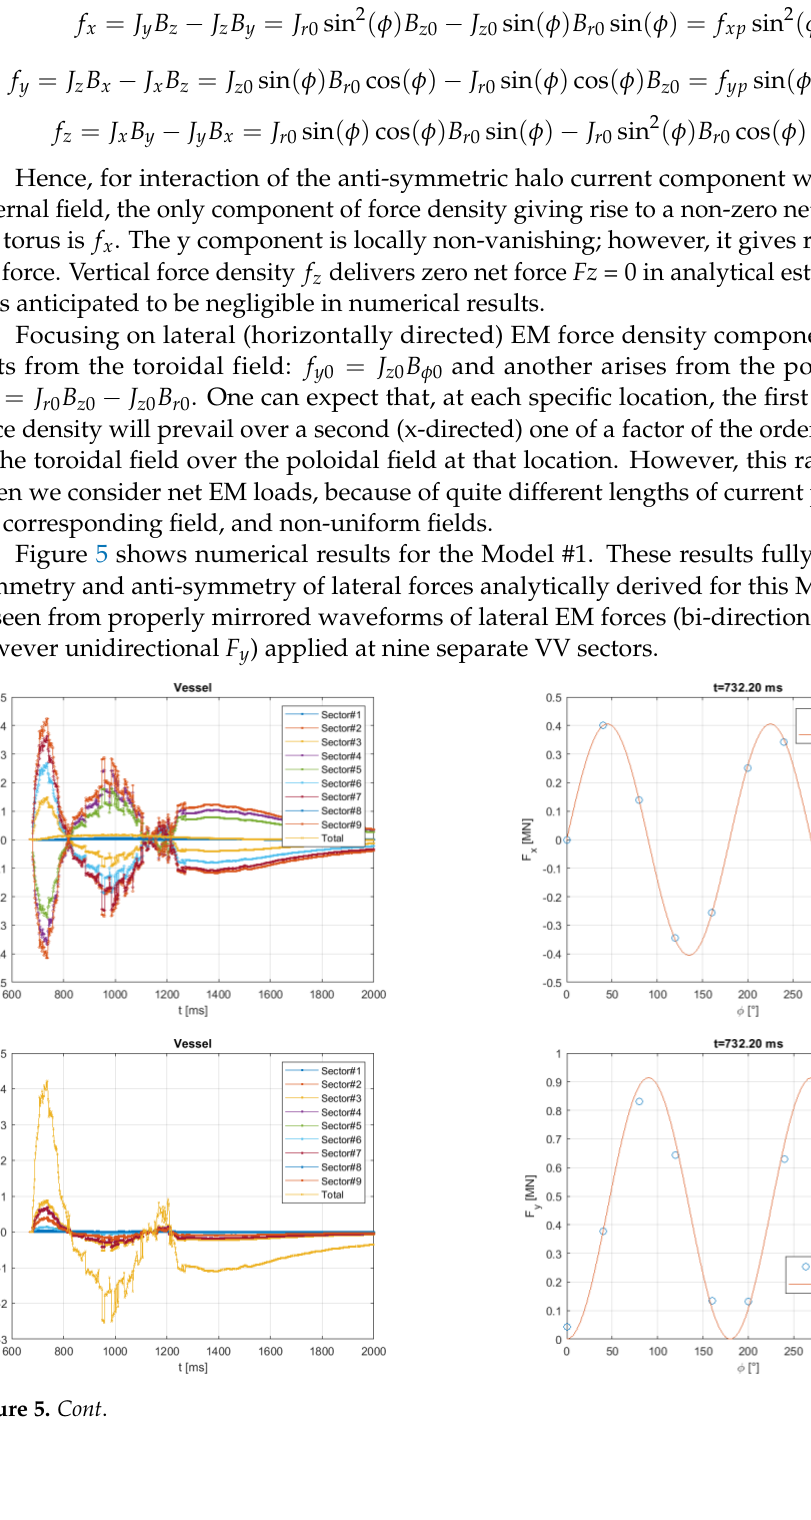
Figure 5. Force Cartesian components created in 9 sectors of the vessel itself due to interaction of the anti-symmetric halo current component in VV with external toroidal magnetic fields, for the Model #1. 6. Model #2 of Bridges for the Perfectly Anti-Symmetric Halo Current Component The main advantage of the first model presented in previous section is that it simu- lates gradual slipping of the halo current “injection belts” down along the first wall, ex- actly in the same way as already done in VDE post-processing, e.g., in [6]. However, as a main disadvantage, it does not reproduce details of magnetic fields caused by asymmetric distortion of helical current in the plasma Halo layer; thus, it does not reflect the interac- tion of helically distorted magnetic fields with all currents, neither does it reflect helical eddy currents in VV with internals, and, accordingly, misses some components of asym- metric loads applied at VV and the Magnets. This section describes a new model of helical bridges for the perfectly anti-symmetric halo current component proposed by this article. It is marked as Model #2 and illustrated by Figures 6 and 7, with results presented in Figures 8 and 9. It uses the same mesh of VV with internals as shown in Figure 3, but differs from the model#1 by helical (not poloidal) bridges closing the anti-symmetric halo currents around plasma. Figure 6 shows only these helical bridges, but not the rest of the FE model already presented in Figure 3. Right now, Model #2 assumes fixed location of the halo current injection belts. We can say that, in comparison with Model #1, Model #2 has both main features in- verted. It represents, as far as possible, the helical pattern of anti-symmetric halo currents in a course of AVDE; however, it still waits for upgrade to the gradually slipping halo